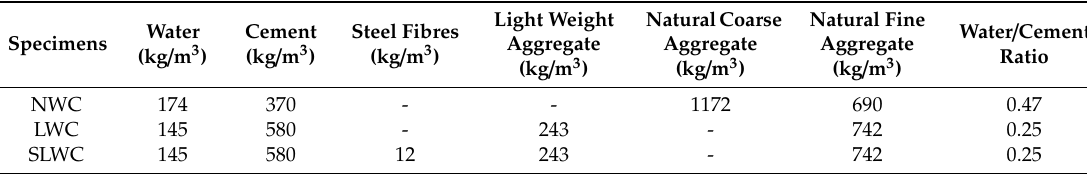
Table 1. Concrete mix designs.